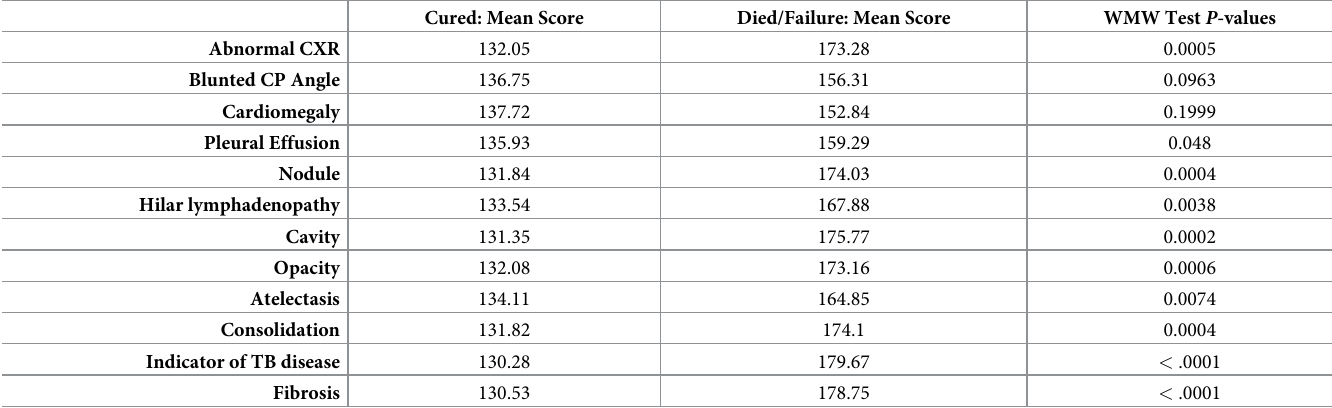
Table 11. 281 Qure.ai continuous classifier score predicting TBPP outcome.